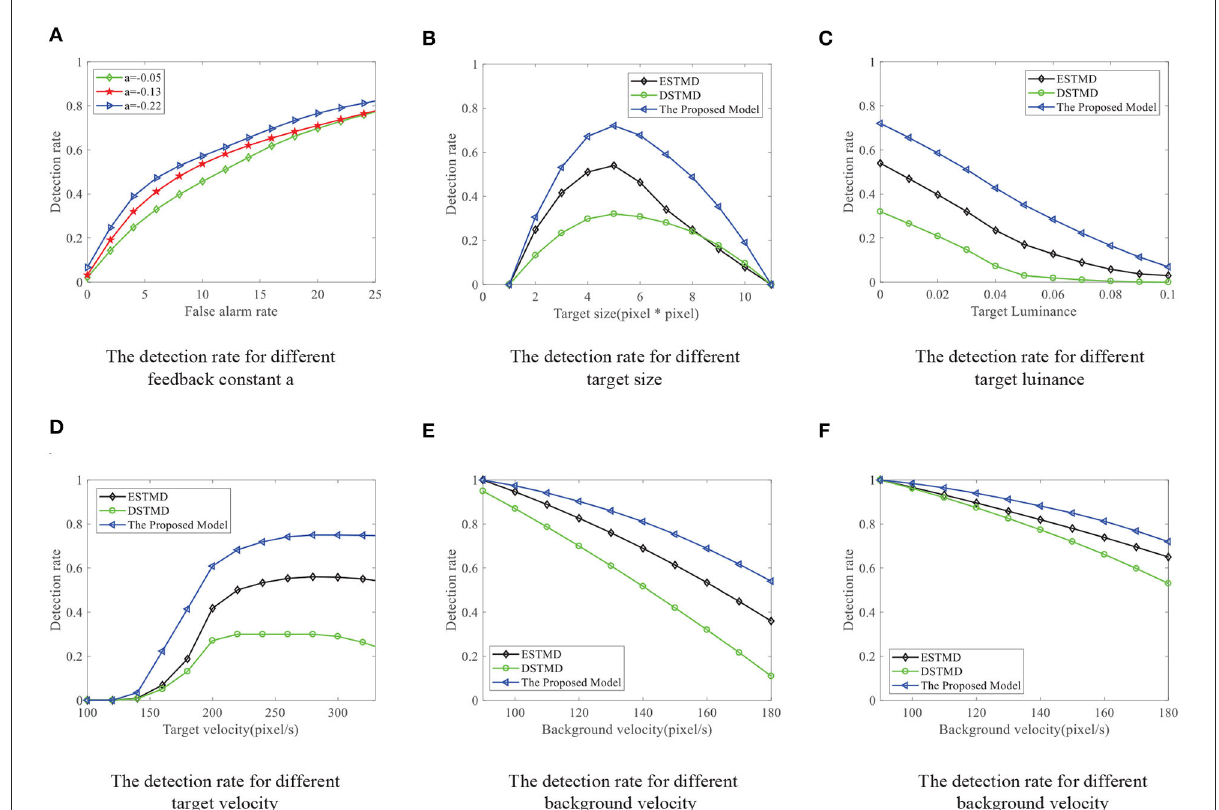
FIGURE12 (A) The D R F A curves of the F STMD for different feedback constant a . (B–F) The D R − sizes, (C) different target luminance, (D) different target velocities, (E) different background velocities, and (F) different background velocities (leftward motion) with the fixed false alarm rate (FA =